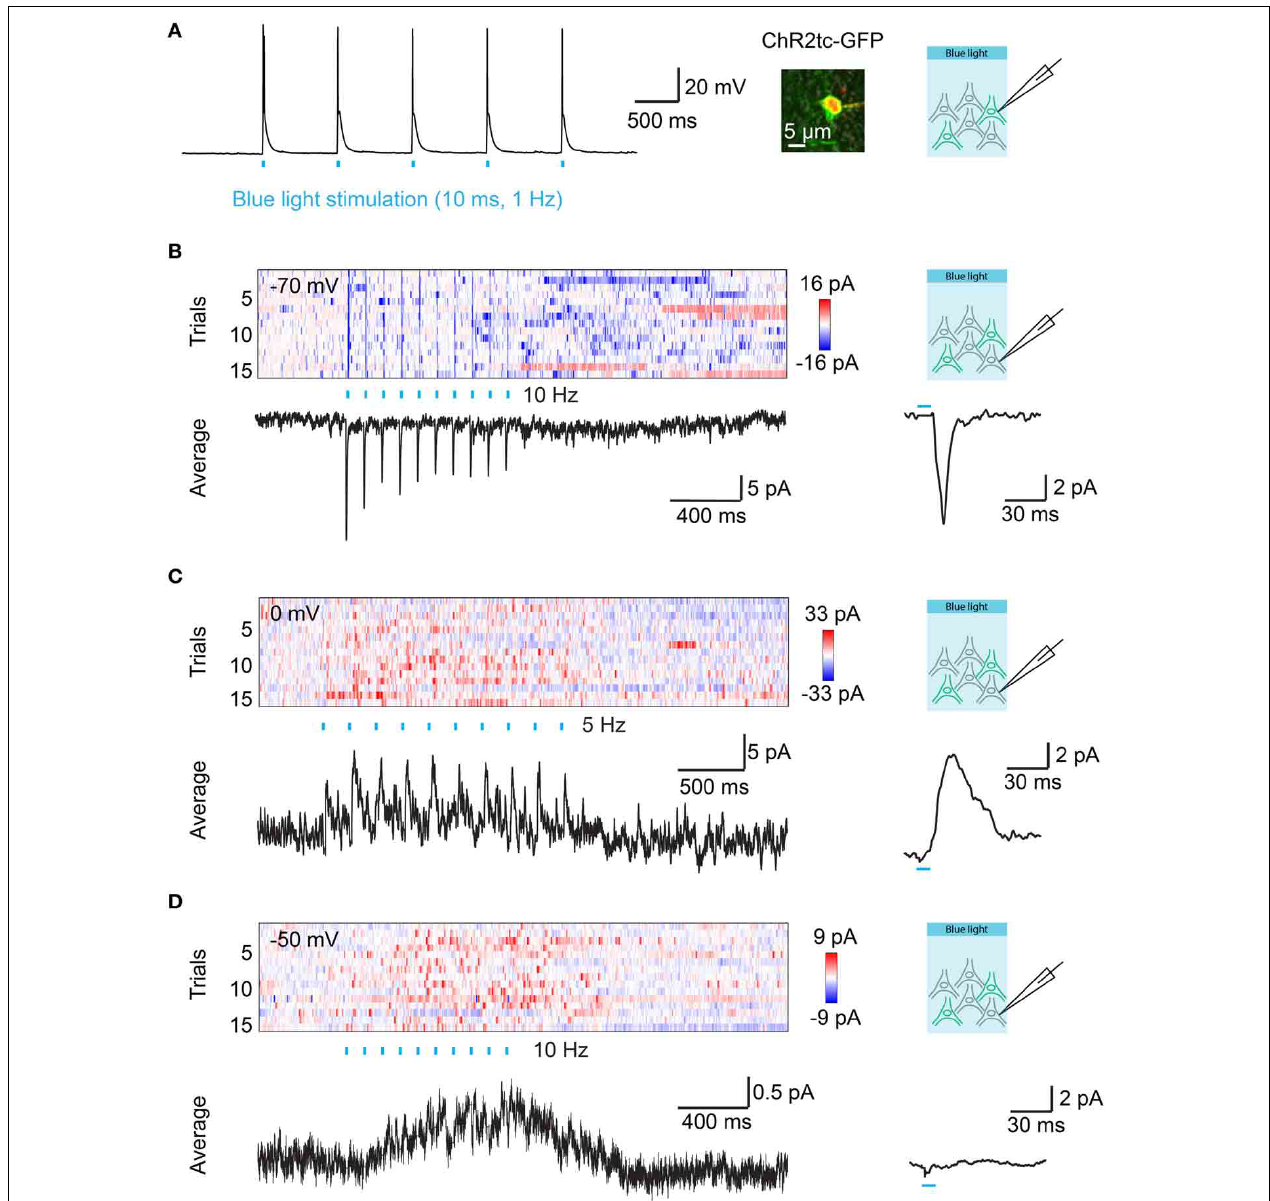
FIGURE 4 | Optical control of synaptic transmission after targeted electroporation of channelrhodopsin-2 in Dp. (A) Action potentials evoked by blue light pulses (10ms; 1Hz) in a Dp neuron expressing ChR2tc-GFP after targeted IEP of plasmid #2. Image shows overlay of GFP fluorescence (green), Alexa594 fluorescence (red; included in pipette solution), and transmitted light (gray) images. (B) Color plot shows currents recorded at a holding potential of − 70mV in a ChR2tc-GFP-negative Dp neuron as a function of time. ChR2tc-GFP was expressed in other Dp neurons by targeted IEP of plasmid #2. Rows represent successive trials. Blue ticks indicate pulses of blue light to stimulate ChR2tc-GFP-expressing Dp neurons